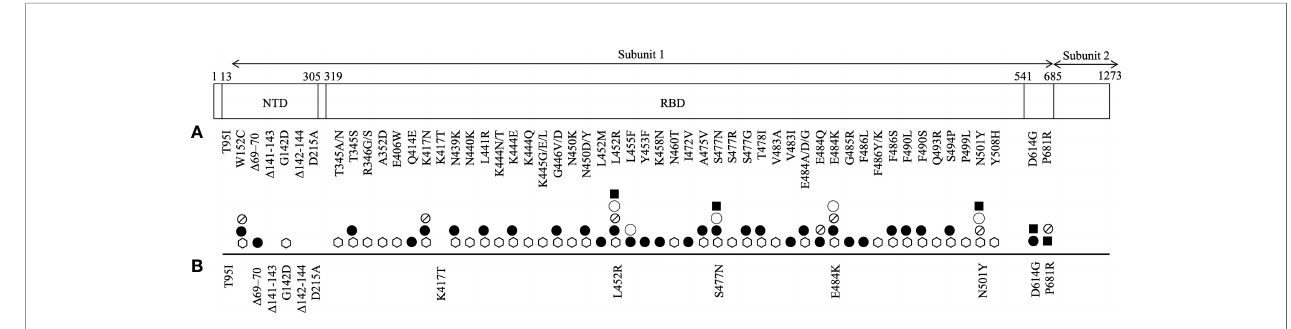
FIGURE 1 | An illustration of SARS-CoV-2 spike protein mutations identi fi ed in its subunit 1 that have been (A) shown to promote resistance to neutralizing monoclonal antibodies ( ⎔ ) and serum antibodies (from convalescent ( ● ) and/or vaccinated ( ⦰ ) individuals), and increase the protein af fi nity to ACE2 receptor ( ◯ ) and viral infectivity ( ■ ) and (B) reported in breakthrough and/or secondary